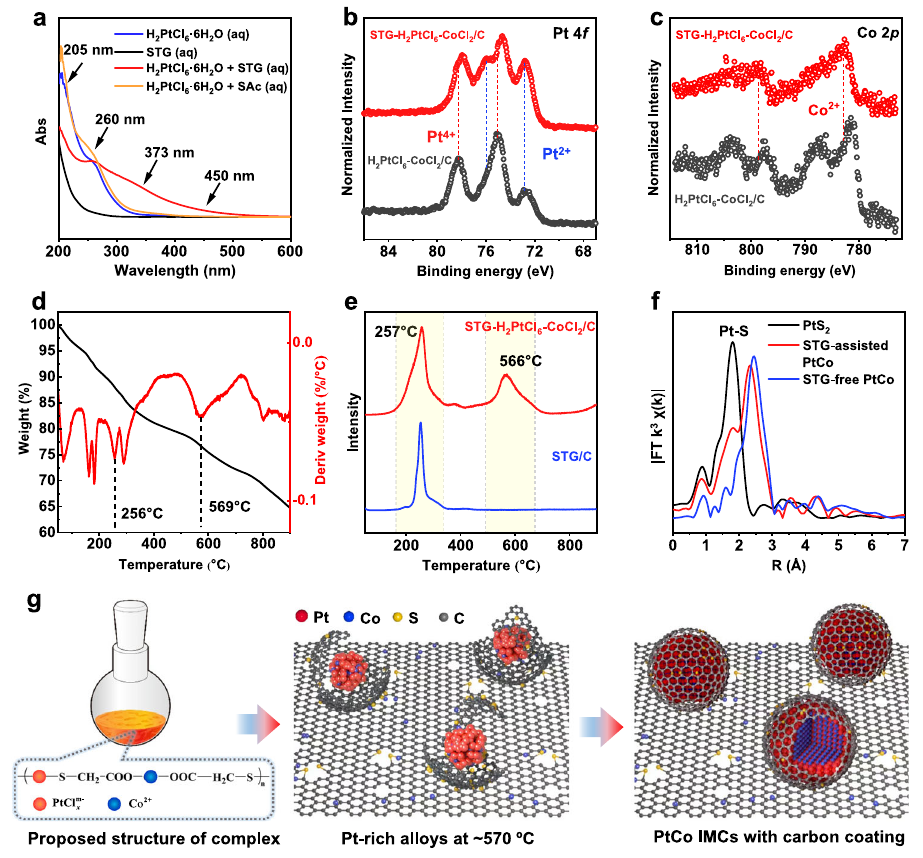
Fig.5|Anti-sinteringmechanism.a UV – VisspectraoftheH 2 PtCl 6 ·6H 2 Osolution, STG solution, the H 2 PtCl 6 ·6H 2 O/STG solution, and the H 2 PtCl 6 ·6H 2 O/SAc solution. XPS results of the Pt 4 f ( b ) and Co 2 p ( c ) orbits of the STG-PtCo/C precursor powder and PtCo/C precursor powder. d TG result of STG-PtCo/C raw